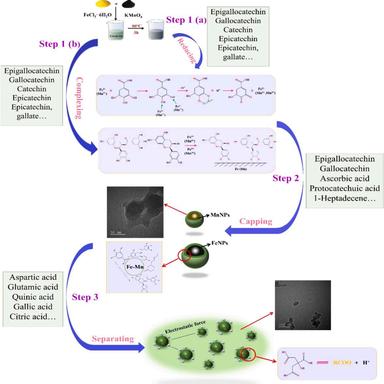
Diagram of the proposed mechanism of Fe–Mn NPs synthesis.